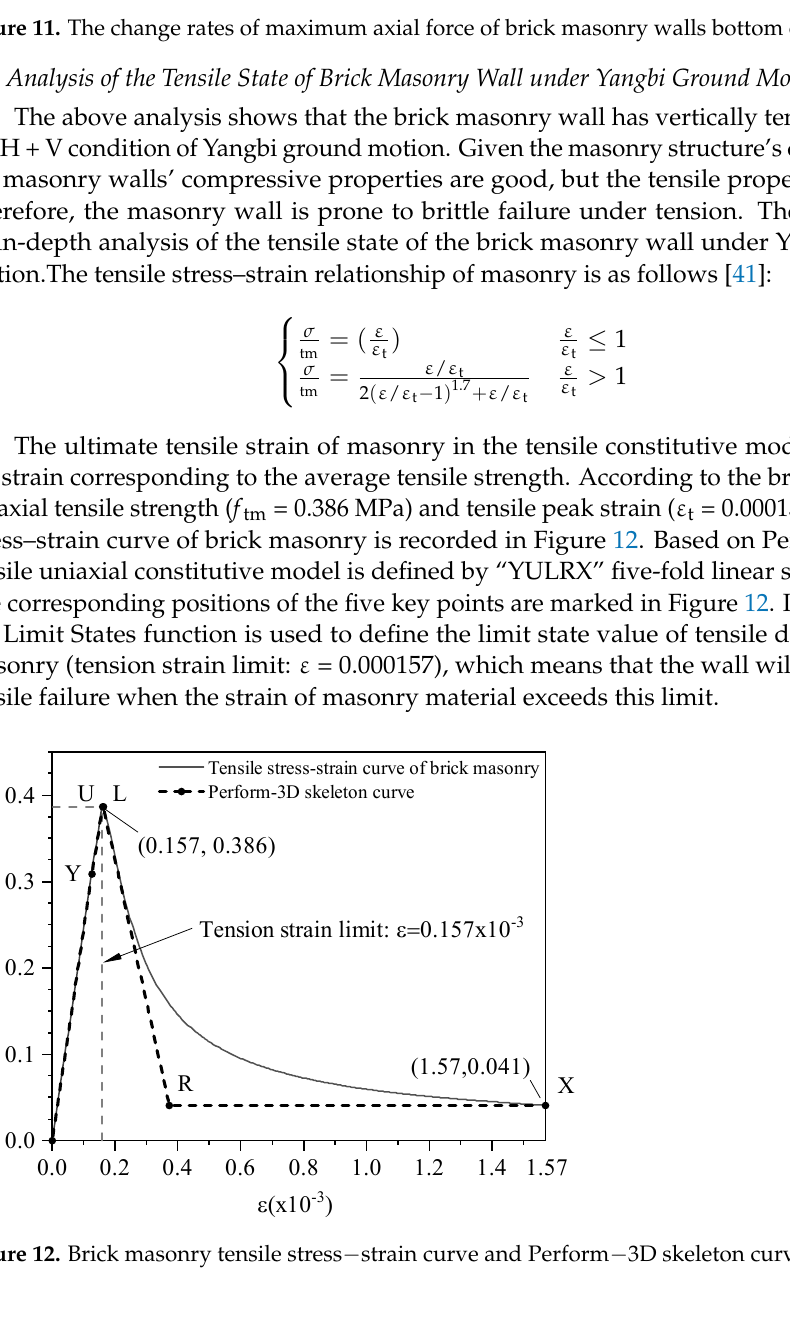
Figure 12. Brick masonry tensile stress − strain curve and Perform − 3D skeleton curve.